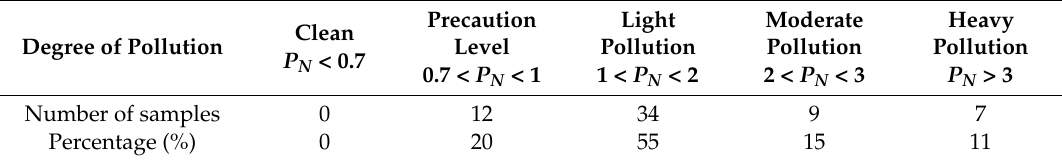
Table 3. Evaluated results of PHMs pollution in soils (%).